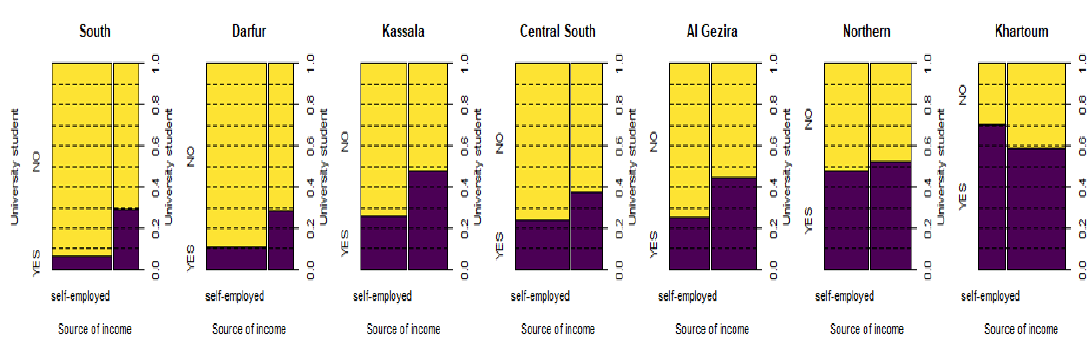
Figure 5. University attendance rates by source of income (self-employed or salaried) for 19–21-year-olds, by